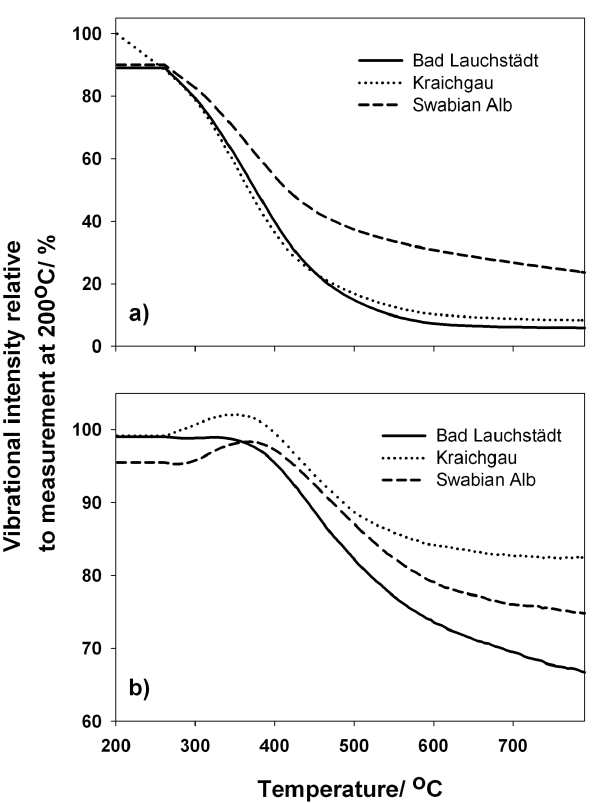
Figure 10 Fig. 10. In situ T DRIFTS of the bulk soil and fractions of (a) C-H (2930cm − 1 ) vibrations and (b) C = O/C = C (1620cm − 1 ) vibra- tions. Average of Kraichgau and Swabian Alb